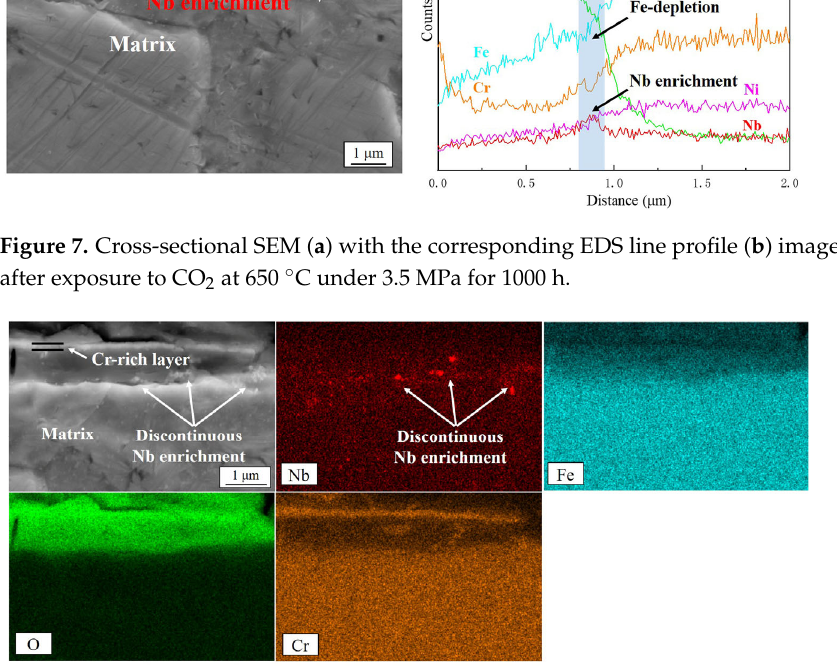
Figure 8. Cross-sectional SEM with the corresponding EDS mapping images of sample S2 after ex-